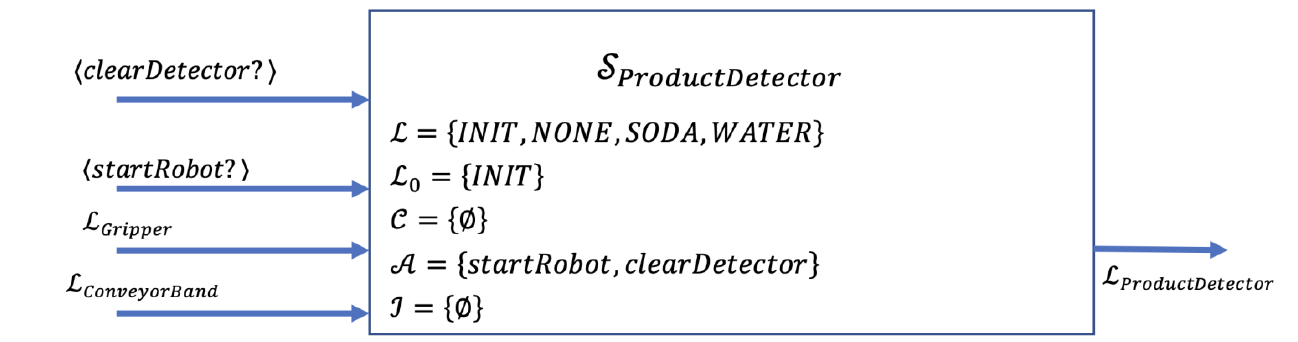
Figure 11. Block diagram of the product detector module.